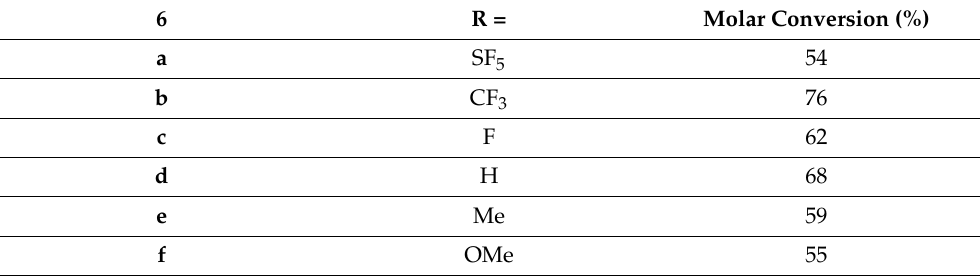
Table 1. Molar conversion of PTAD-tyrosine conjugate products ( 6a – f ) using HFIP/DCM solvent system, as determined via 1